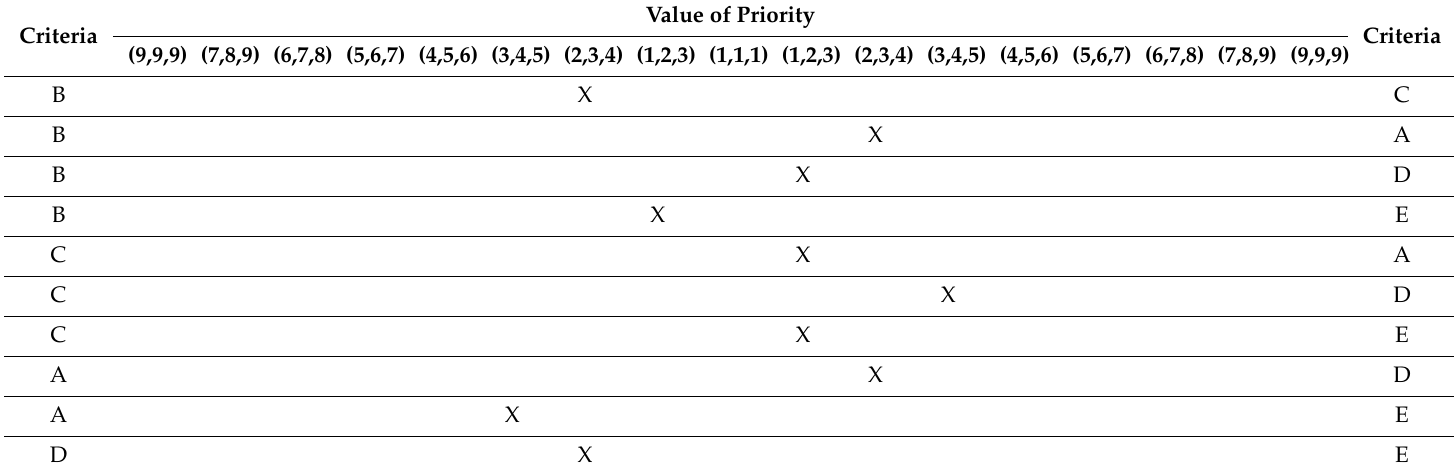
Table 7. Compare pairs of the main